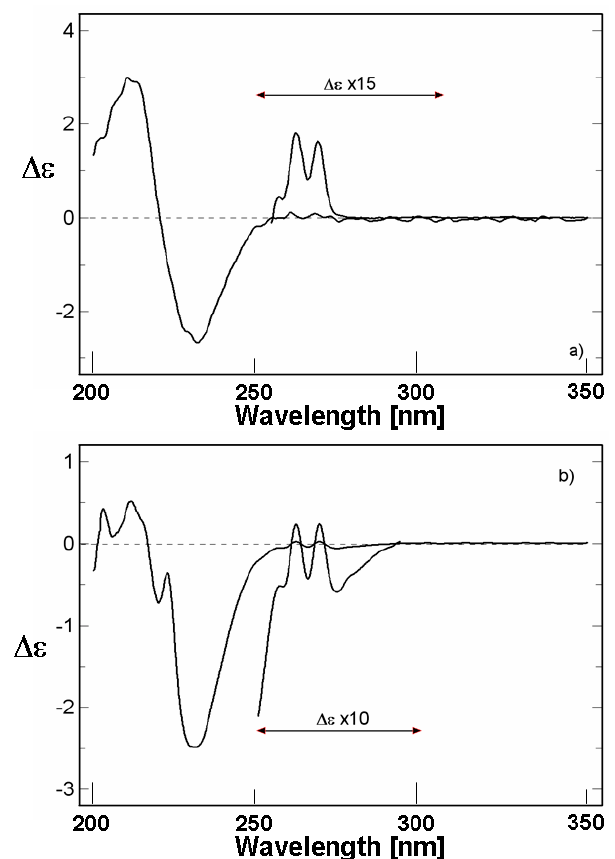
Figure 4. ( a ) CD spectrum of a diluted ethanolic solution of ( − )[( S ) S ( S ) C -Et(PhBu)S.2HgCl 2 , ( II ); ( b ) CD spectrum of an ethanolic solution of ( − )[( S ) S ( S ) C -Et(PhBu)S.2HgCl 2 , ( II ) after the addition of 200 mmol of HgCl 2